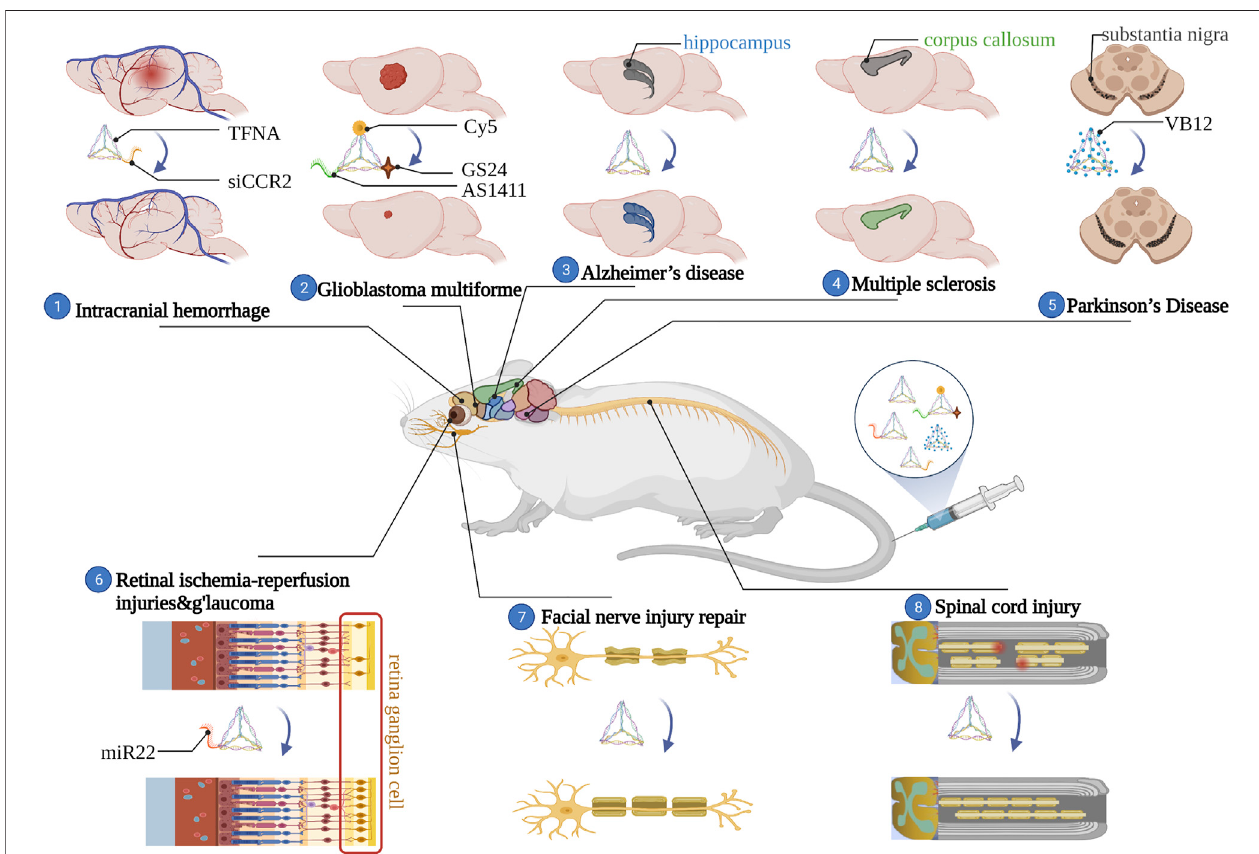
FIGURE 4 | Application of tFNA-based nanomaterials in neurological